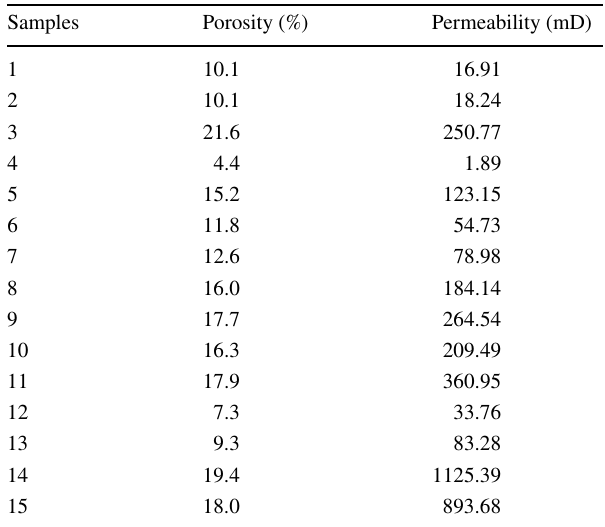
Fig. 3 Porosity versus permeability of the studied samples Table 1 Porosity and permeability measured values of studied sam- ples